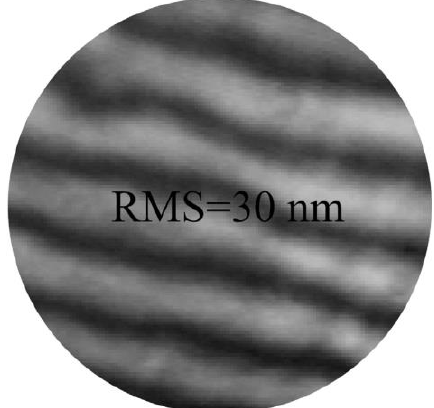
Figure 6. Thickness uniformity of a membrane in 200 mm